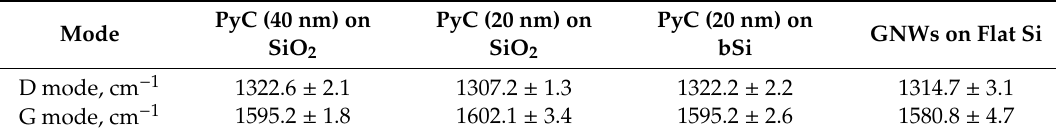
Figure 3. Raman spectra of PyC (40 nm) on SiO 2 , PyC (20 nm) on SiO 2 , PyC (20 nm) on bSi, and graphene nanowalls. λ ex = 785 nm. Presented spectra are average spectra from triplicates. All scales are marked with corresponding scale bars on each individual spectrum. Table 2. Raman spectra characteristic modes of carbon multilayered materials deposited on different substrates.